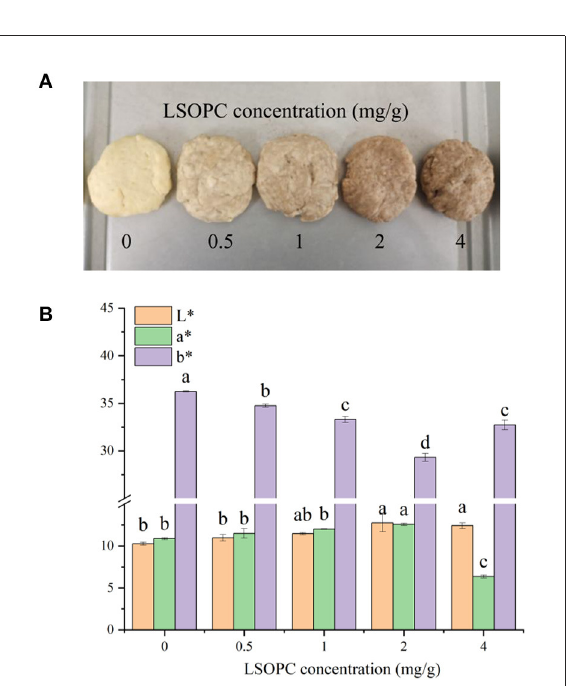
FIGURE7 Original images of biscuits (A) . Chromatic value of toughed biscuit and the biscuits (B) . Significant differences (p < 0.05 ) of data values were indicated by different letters. L*: lightness, a*: red/green value, b*: blue/yellow value.